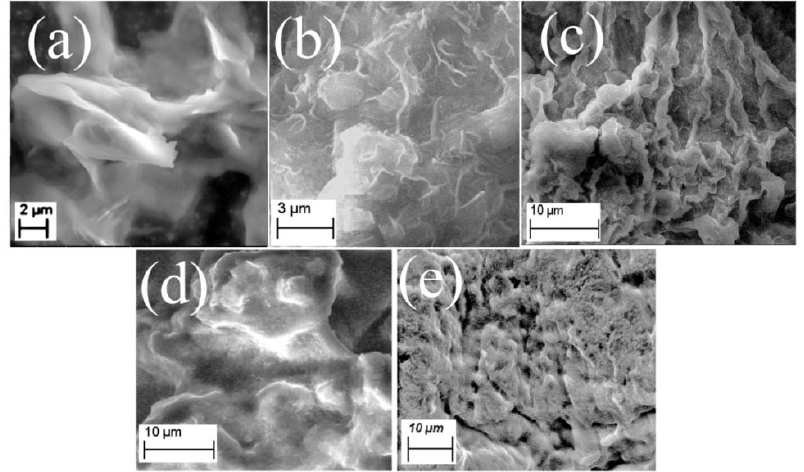
Figure 1. Scanning electron microscopy images depicting layer-by-layer assembly of Construct I. ( a ) FVC fibrous assemblies; ( b ) FVC fibers layered with DSp peptide sequence; ( c ) Incorporation of Type I collagen (Col-I) to FVC-DSp; ( d ) Incorporation of chitosan (Ch)